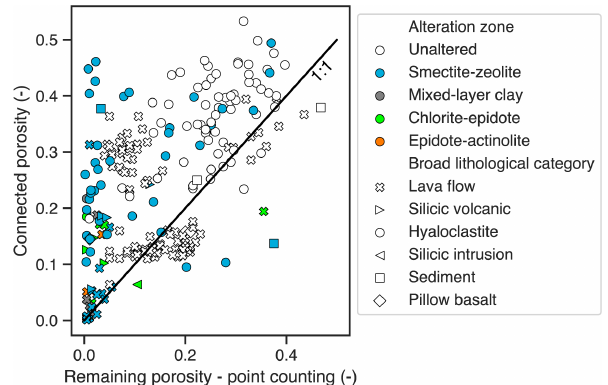
Figure 5. Remaining porosity estimated by point counting com- pared with connected porosity measured using He